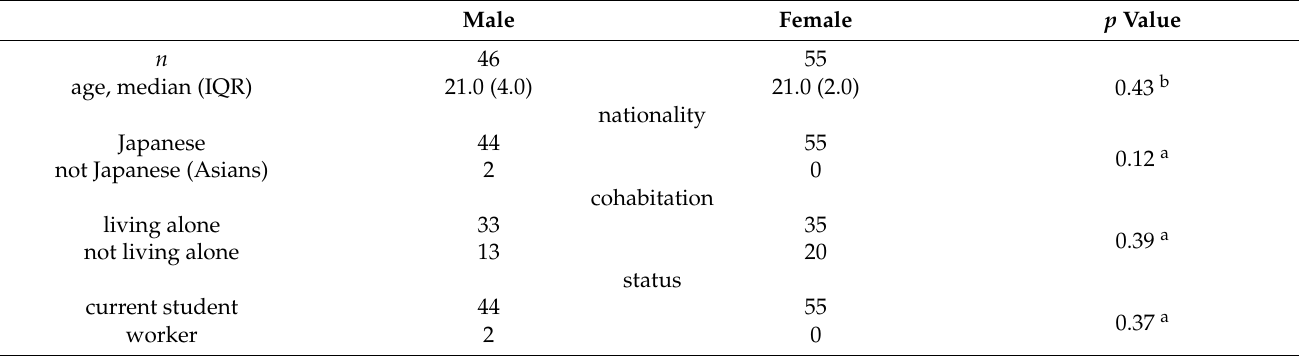
Table 2. Demographic data.